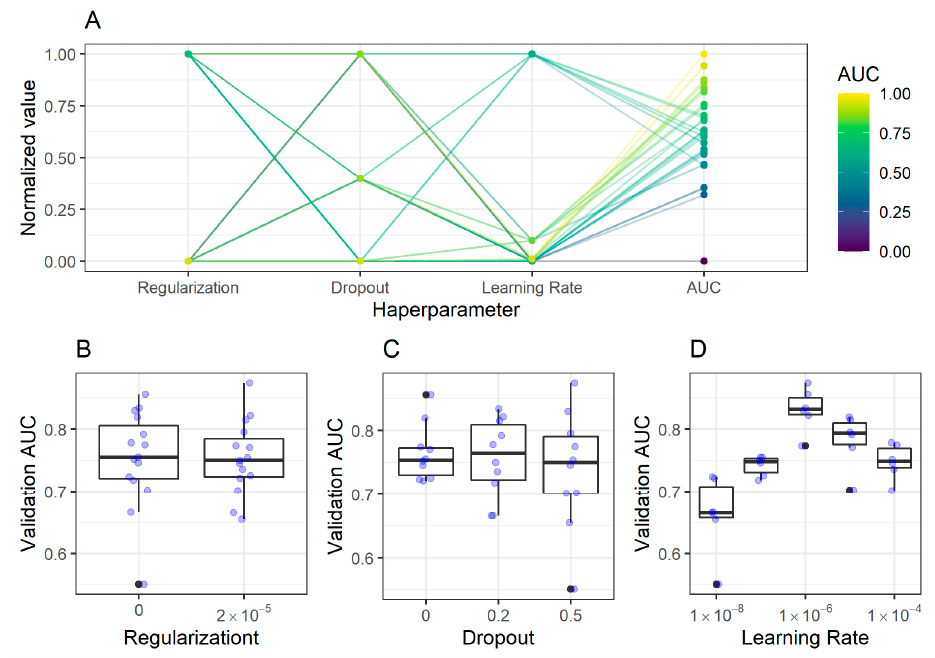
Figure 3. Impact of hyperparameters on the validation Area Under the receiver operator characteristics Curve (AUC) in classification of antrum image patches. ( A ) The coordinates plot shows the dependency of hyperparameters and resulting AUC for different trained models shown as dots.